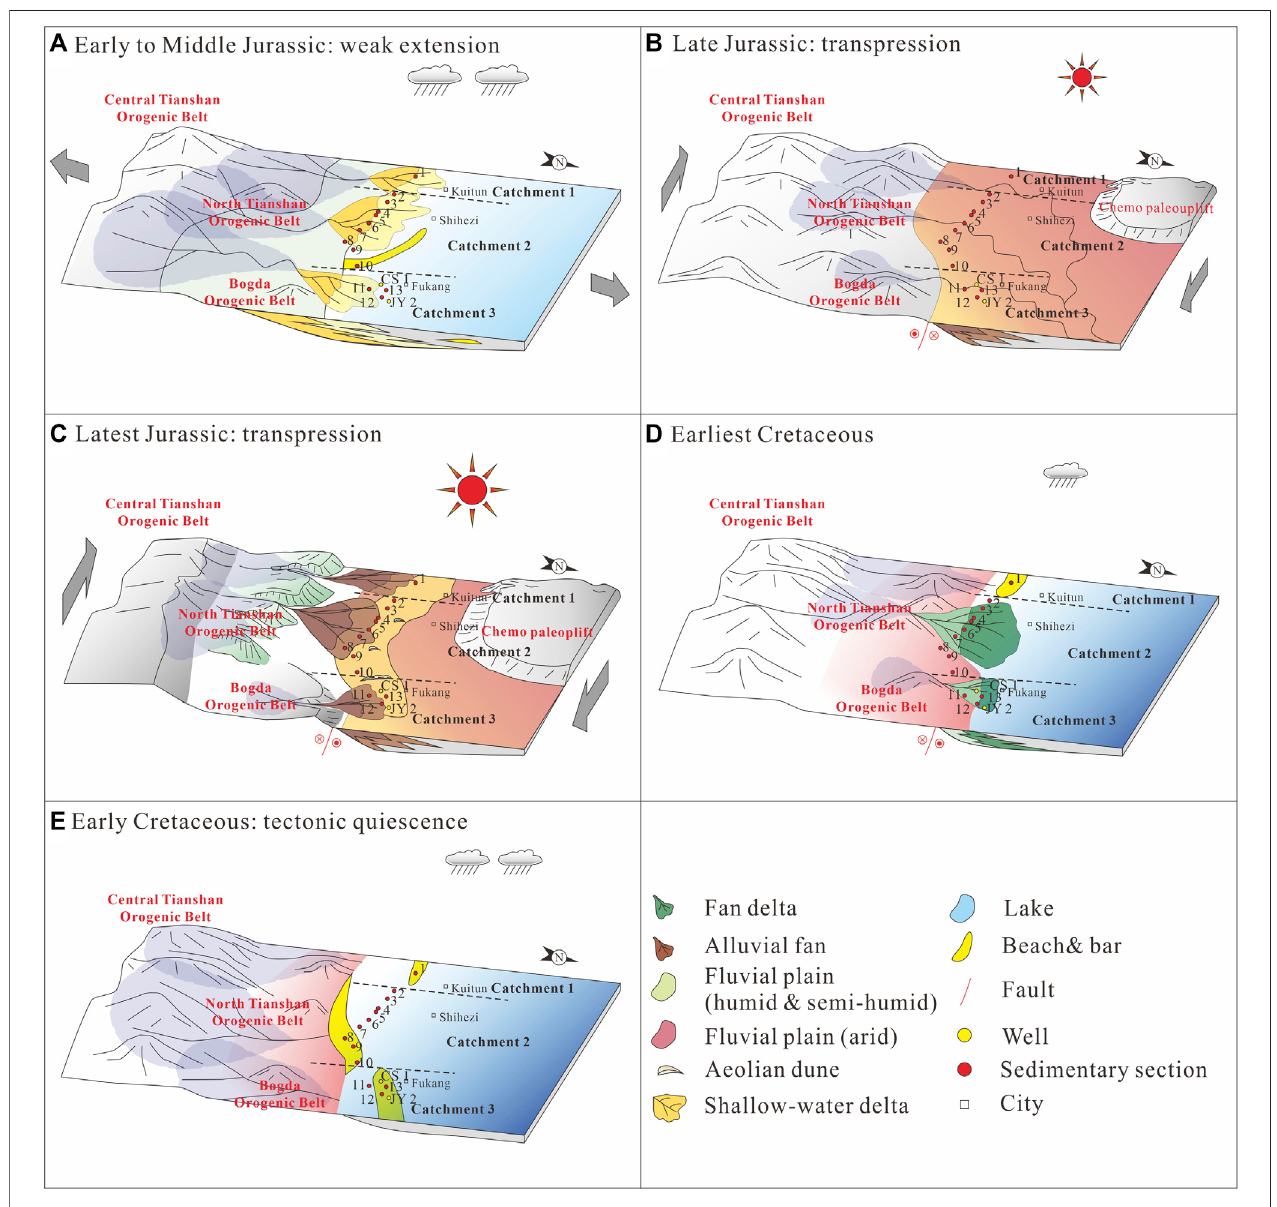
FIGURE11 | Sedimentaryand source-to-sink system evolution in theSouthern Junggar Basinin the lateMesozoic. (A) EarlytoMiddle Jurassic; (B) LateJurassic; (C) latest Jurassic; (D) earliest Cretaceous; (E) Early Cretaceous. North Tianshan- North Tianshan; Central Tianshan- Central Tianshan. 1. Sikeshu River section; 2. Manasi section; 3. Qingshuihe River section; 4. Taxi River section; 5. Quergou section; 6. Hutubi section; 7. Jiangong mine section; 8. Dongwozi section; 9. Toutunhe section; 10. Wangjiagou section; 11. Baiyanggou section; 12. Shuimogou section; 13. Dahongshan section.